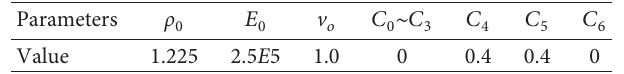
Table 3: Parameters of the air model and the state equation. Parameters